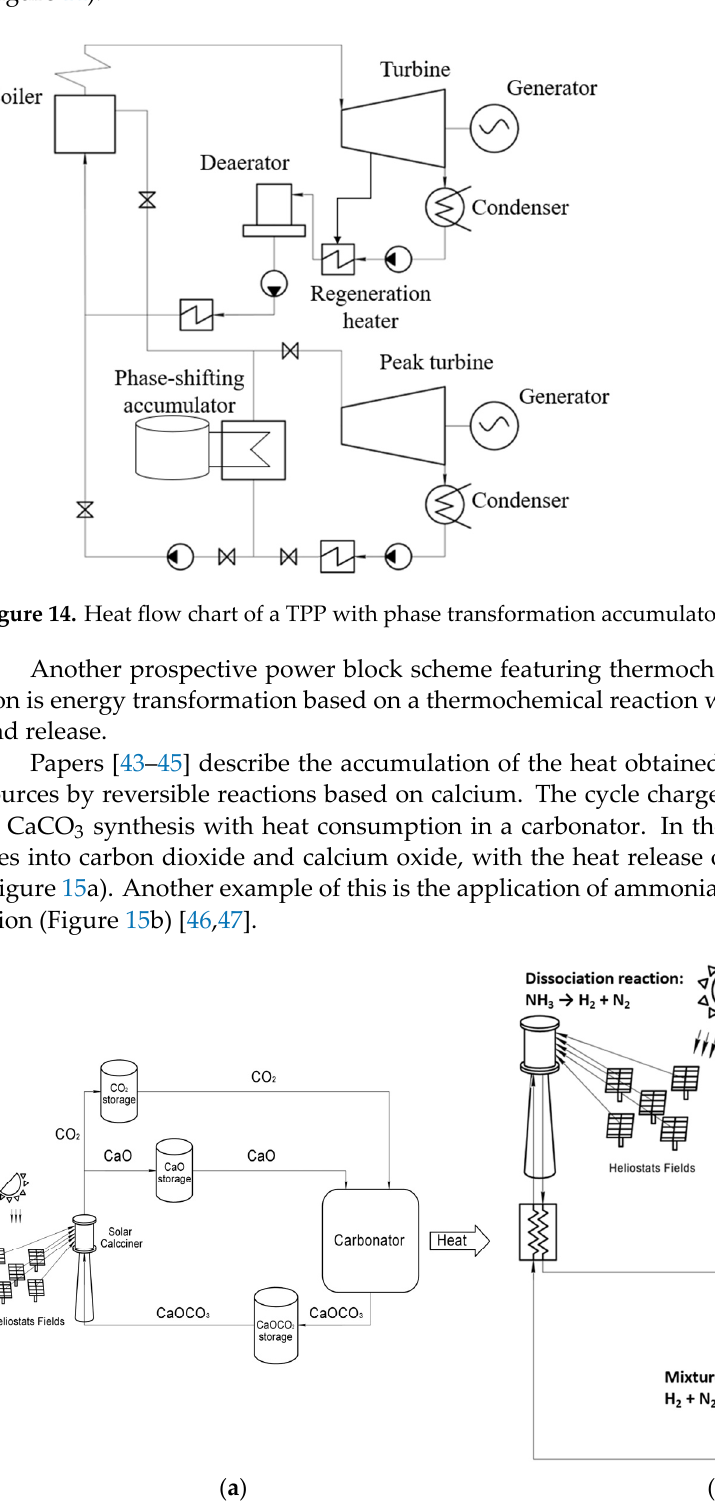
Figure 13. Heat flow chart with an intermediate heat carrier.